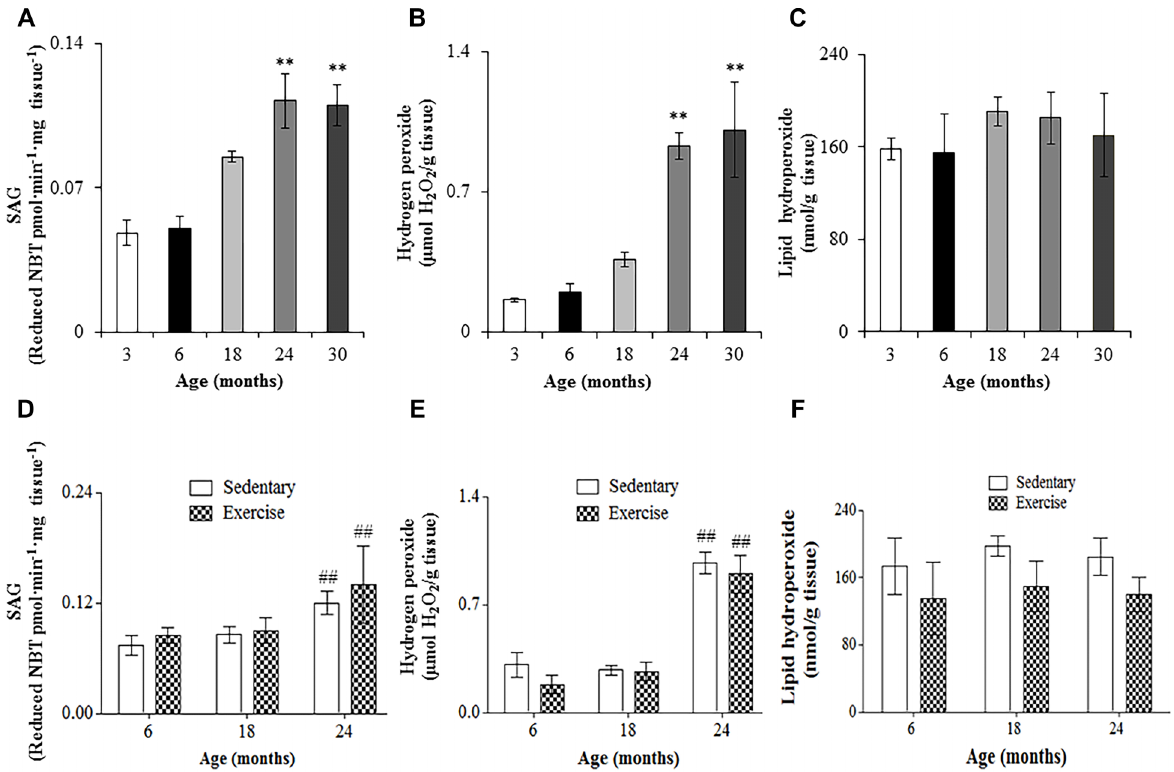
Figure 8. Superoxide anion generation (SAG) ( A , D ), hydrogen peroxide ( B , E ), and lipid hydroperoxide ( C , F ) levels in the lumbosacral spinal cord of Wistar rats of different ages ( A – C ) and after 12 weeks of treadmill running ( D – F ). Data are reported as mean ± SE. **P o 0.05 compared to 3-, 6-, and 18-month-old rats; ## P o 0.05 compared to 6- and 18-month-old rats (one-way ( A – C ) and two-way ( D – F ) ANOVA followed by Tukey ’ s post hoc